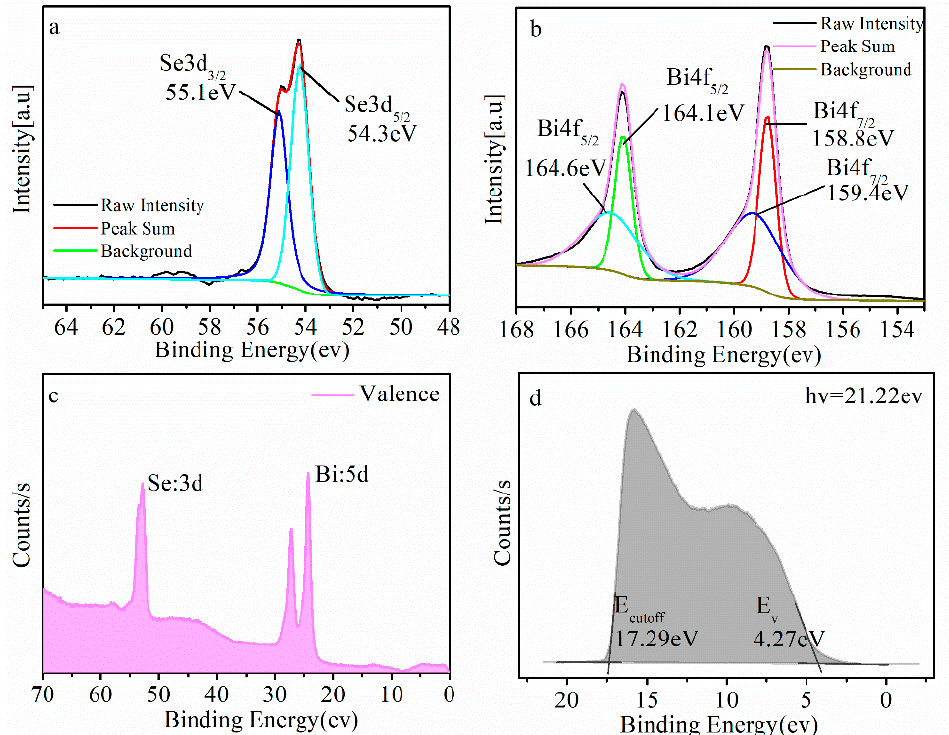
Figure 3. XPS analysis of Bi 2 Se 3 /LSMO/LAO with t = 8 min; ( a ) the Se 3 d peaks; ( b ) the Bi 4 f peaks. ( c ) Valence-level measurements on Bi 2 Se 3 /LSMO/LAO taken with 100 eV photons. ( d ) UPS spectra of Bi 2 Se 3 /LSMO/LAO.